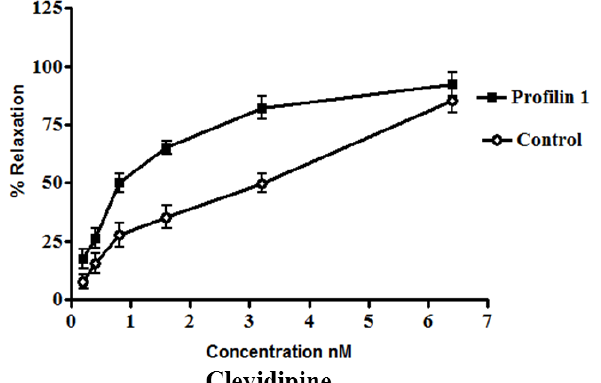
Figure 1. Effect of clevidipine on phenylephrine-contracted profilin1 mesenteric